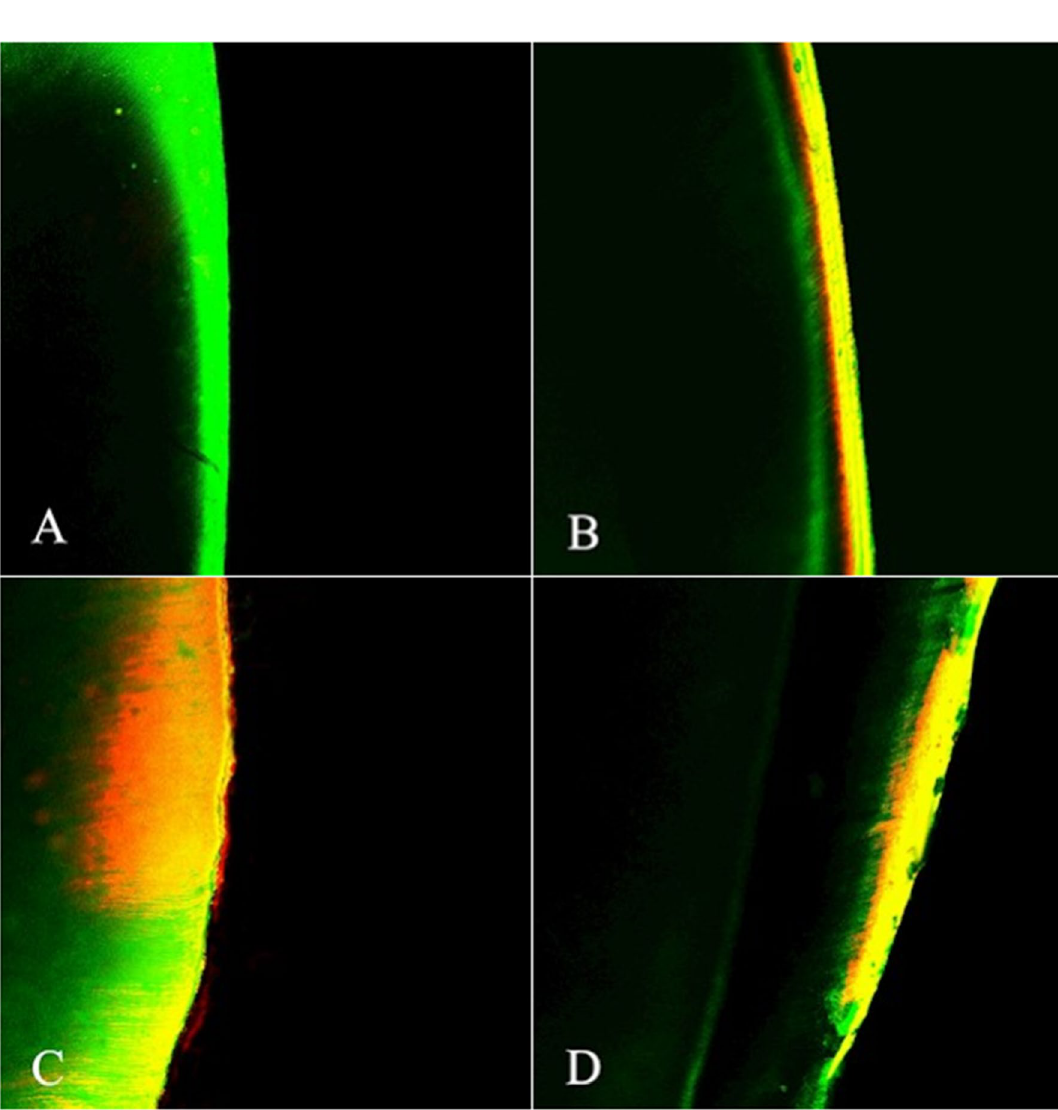
Figure 2. Confocal laser scanning microscopy image the enamel after: ( A ) Demineralization (control group), ( B ) Fissure sealant penetration into demineralized enamel treated with 37% phosphoric acid, ( C ) Infiltrant resin that penetrated into demineralized enamel, ( D ) Fissure sealant that penetrated into demineralized enamel treated with 15% hydrochloric acid. Red: Penetration zone of methyl-rhodamine isocyanate (diffusion zone). Green: Penetration zone of sodium fluorescein (demineralized